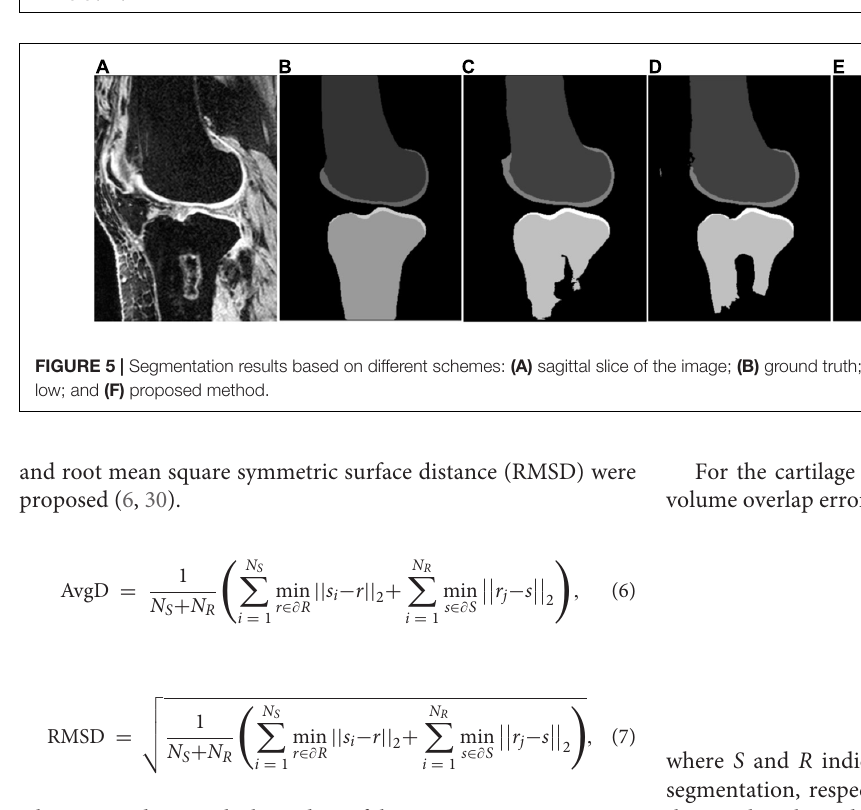
FIGURE 4 | Segmentation results based on different schemes: (A) sagittal slice of the image; (B) ground truth; (C) nnU-Net three-dimensional (3D) full resolution; and (D) proposed method.